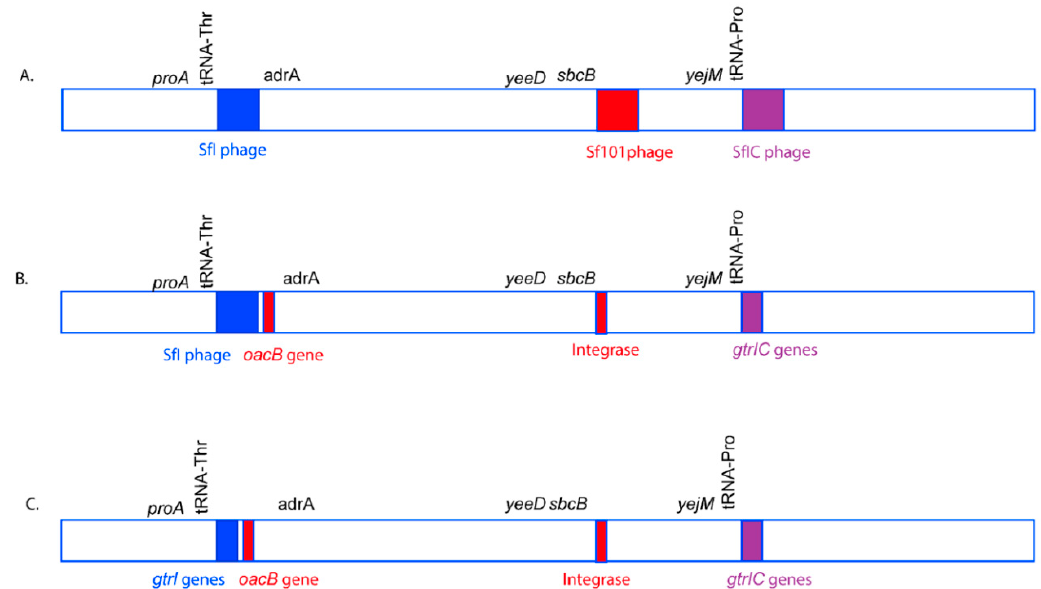
Figure 7. A model of O-antigen modifying phage acquisition in S. flexneri serotype 1c. The genomic region is not drawn to scale. The O-antigen modifying phages, SfI (blue), Sf101 (Red), and SfIC (Purple) integrate in tRNA-Thr , sbcB and tRNA-Pro genes, respectively in the S. flexneri genome to give rise to S. flexneri serotype 1c ( A ). However, over time, most of the structural genes of the phages Sf101 and SfIC are lost due to recombination events. The remnants of Sf101 and SfIC have only a few genes including genes required for serotype conversion. Moreover, the oacB gene has been translocated adjacent to SfI region with the help of transposases ( B ). Furthermore, over time, SfI phage also loses most of its structural components, remaining only a handful of genes including the O-antigen modifying genes. Hence, all the three phages SfI, Sf101 and SfIC remain as remnants in most of the current S. flexneri serotype 1c isolates ( C ).